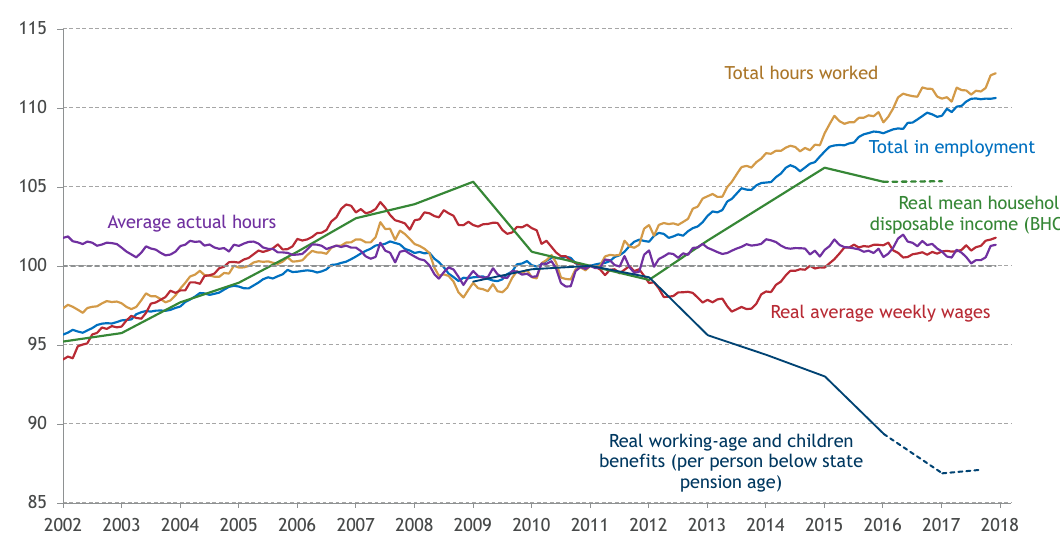
Figure 4: Although weekly wages are lower than they were in 2008, household incomes have held up Employment, hours, earnings, benefits and income (October 2011 =